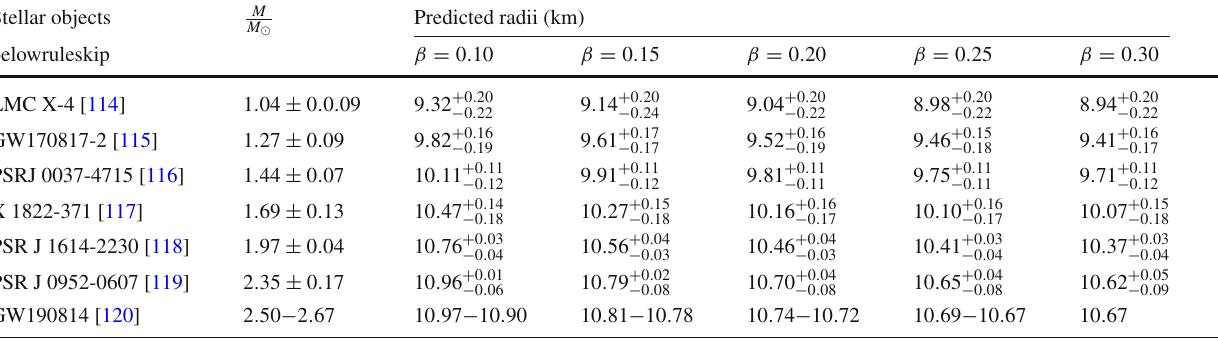
Table 2 Numerical values of the predicted radii of different stars for Solution 5.1 with surface density ρ s (cid:12) 8 × 10 14 gm / cm 3 , A = 0 . 0078 , B = 0 . 0093 ,α = 1 . 2